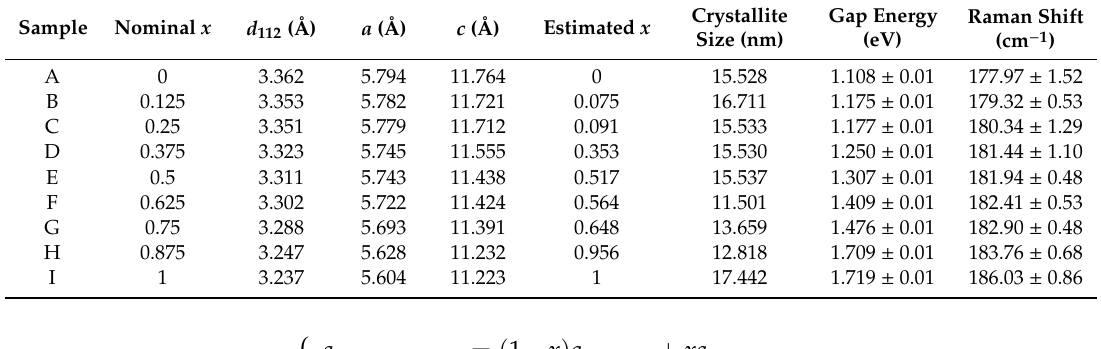
Table 1. Structural and optical parameters of CuIn 1 − x Ga x Se 2 nanocrystals.